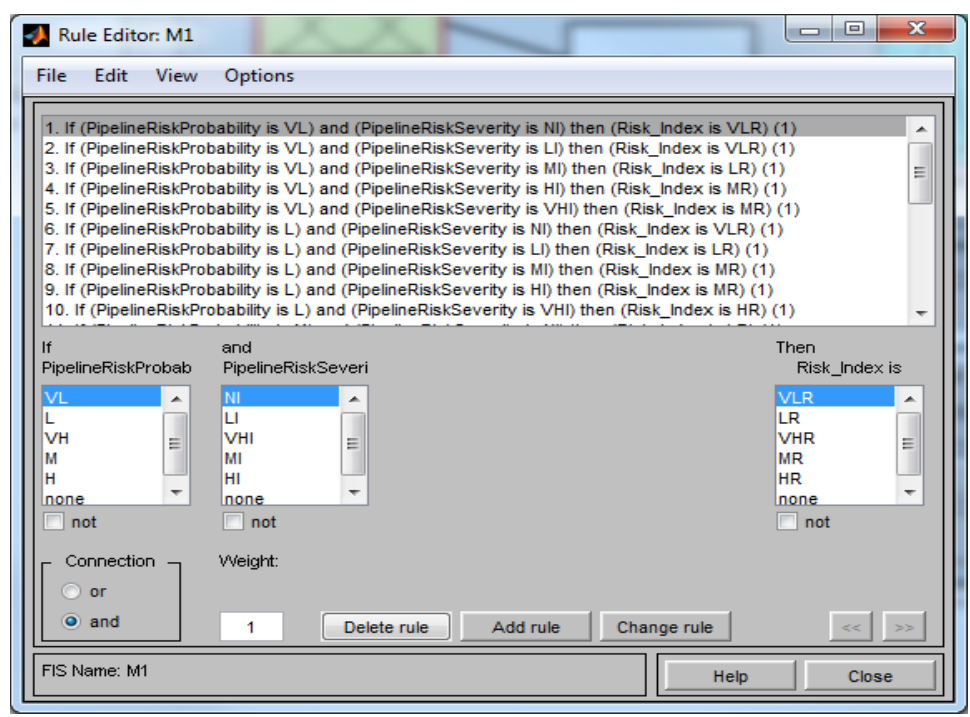
Figure 8. Input/output MFs: ( a ) P 1 ; ( b ) P 2 ; and ( c ) M 1.